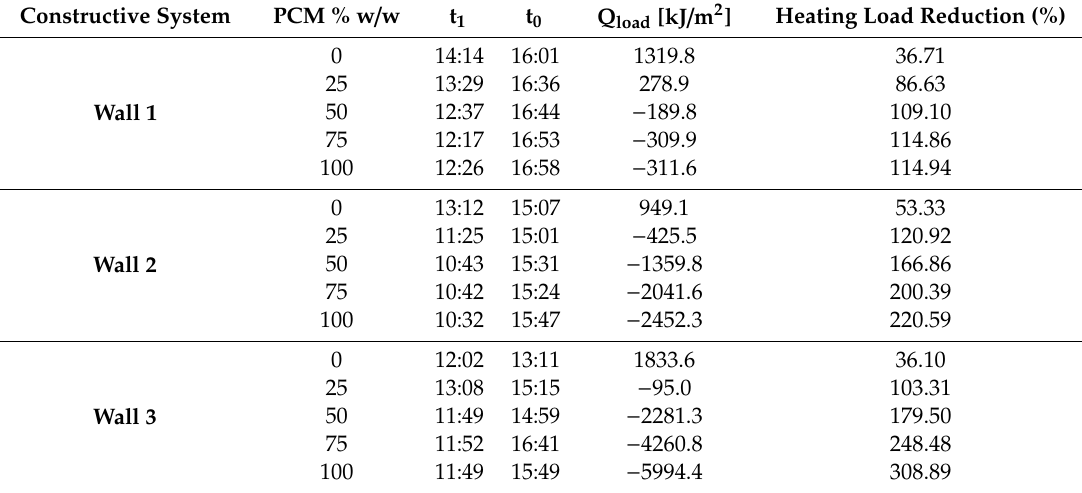
Table 3. Sensitivity analysis of PCM amount in heating load and control parameters by using dynamic system for each constructive